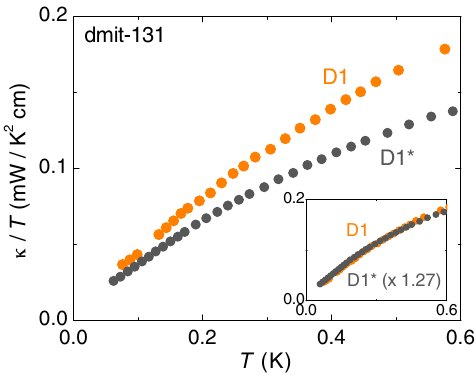
FIG. 3. Same data as in Fig. 1(b) but for sample D1. D 1 ⋆ is the same sample but with contacts rotated in the plane by 90° with respect to D1. Both orientations show the same temperature dependence. As seen in the inset, a multiplicative factor of 1.27 collapses the D 1 ⋆ data onto the D1 data. This shows that there is no large in-plane anisotropy of κ in dmit-131.